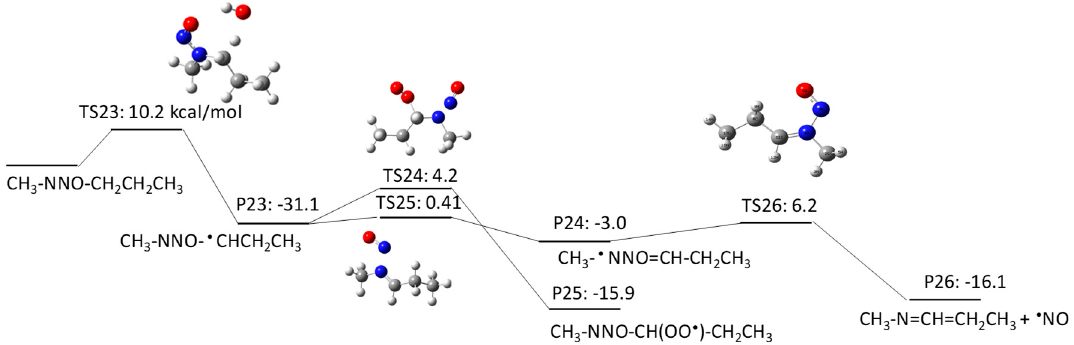
Figure 7. Free energy profile for pathway 3–1 of the HO • -induced reaction pathways for NMBA via H abstraction from a C–H bond of the –CH 2 – functional group adjacent to the N–NO functional group. The numbers (kcal/mol) are the free energy of activation for the TS and free energy of reaction for the P relative to the corresponding reactant.